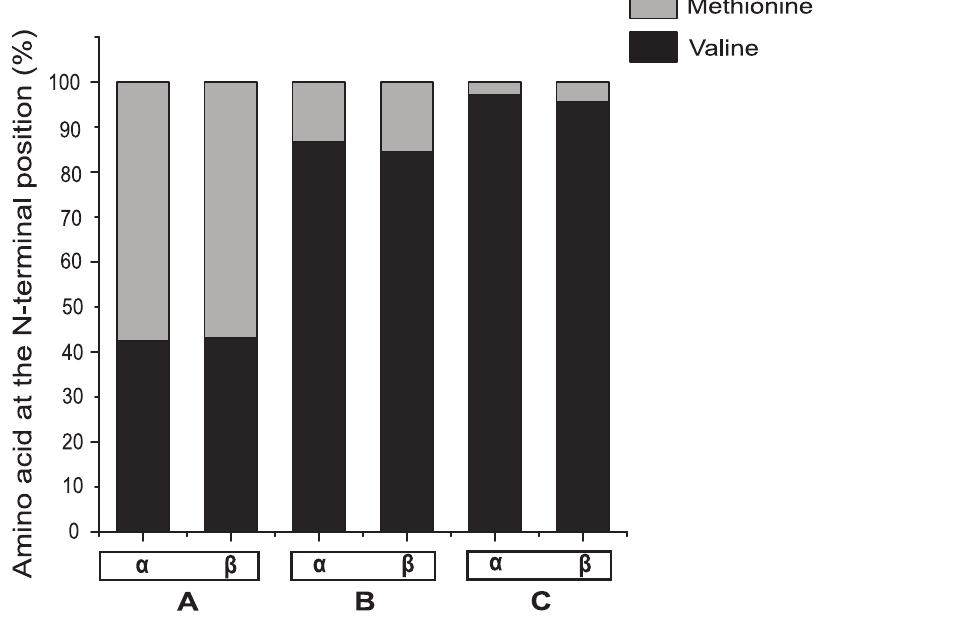
Figure 3. Variation in the efficiency of MAP enzyme in cleaving N-terminal methionine residues from the a - and b -chain subunits of purified HH rHb. The relative fractions of methionine and valine in the N-terminal residue positions are shown for three experimental conditions: (A) BL21Star TM (DE3) at 12 u C for 24 hr, (B) BL21Star TM (DE3) at 30 u C for 4 hr with co-expression of pCO-MAP expression plasmid, and (C) JM109 (DE3) at 28 u C for 16 hr with co-expression of pCO-MAP expression plasmid. The efficiency of the MAP enzyme in cleaving the N-terminal methione residues from the a - and b -chain subunits is indicated by the relative fraction of methionine vs. valine in the N-terminal residue position. When the percentage of globin chains with NA1 valine exceeds 95%, this indicates that the post-translational modification has been carried out